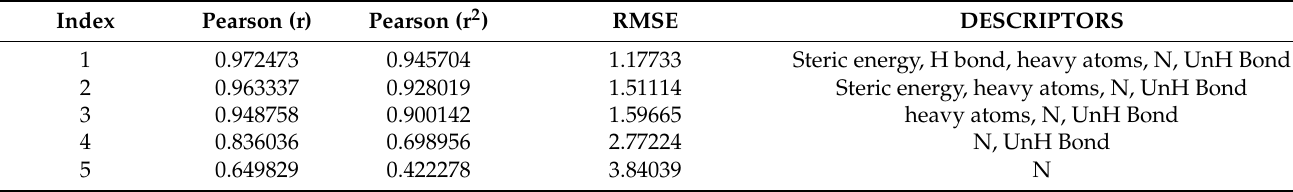
Table 2. Descriptors used in QSAR model for S. aureus .